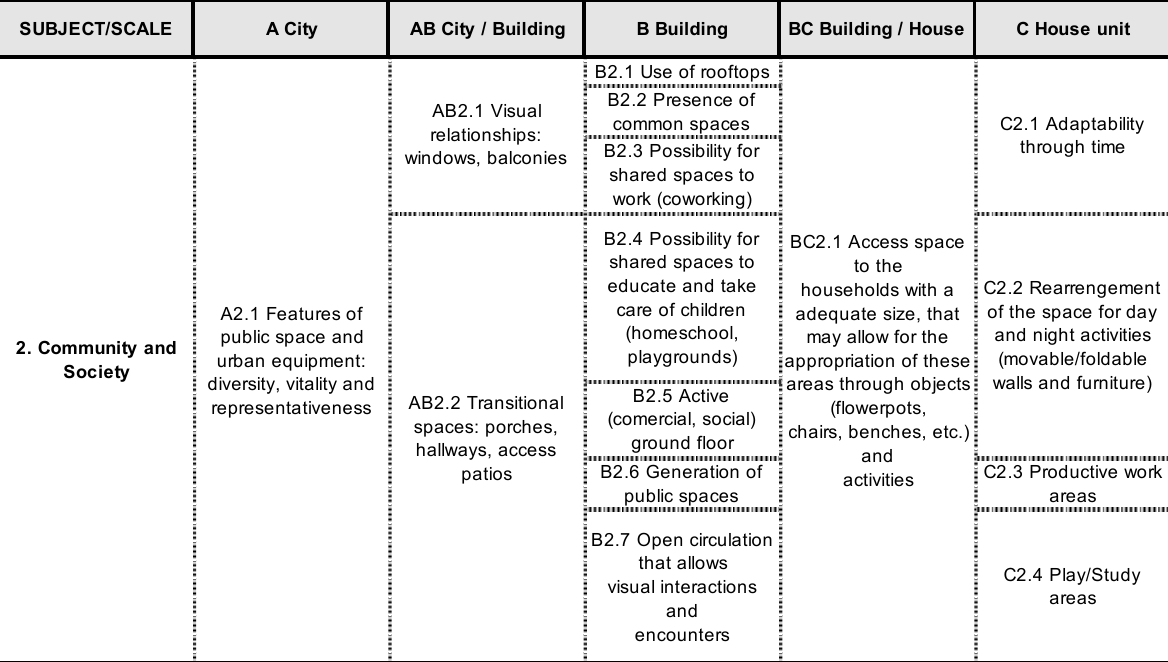
Figure 2. Community and Society Indicators. Source: Own elaboration. Category 3: The Gender and Inclusion indicators bring together all those parameters